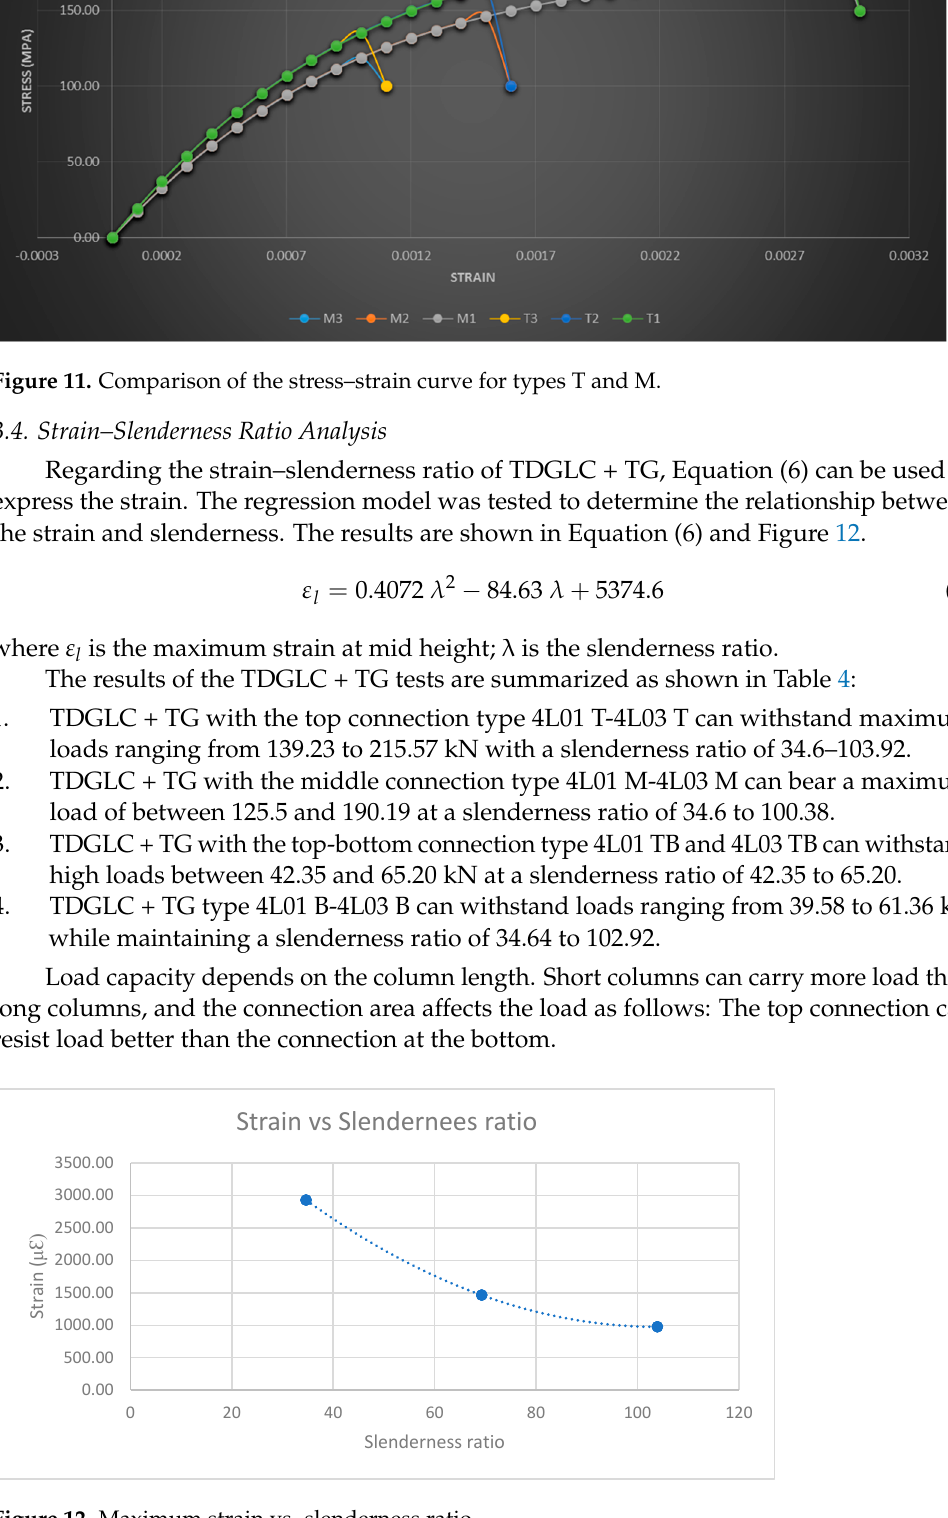
Figure 12. Maximum strain vs. slenderness ratio.